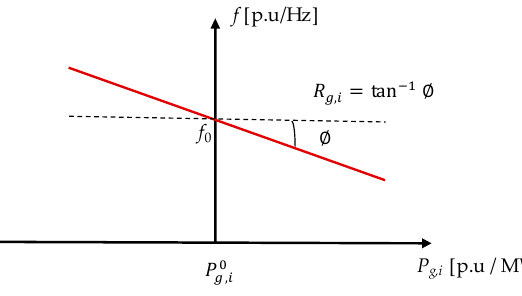
Figure 1. Linear P-f response characteristic of synchronous generator i.